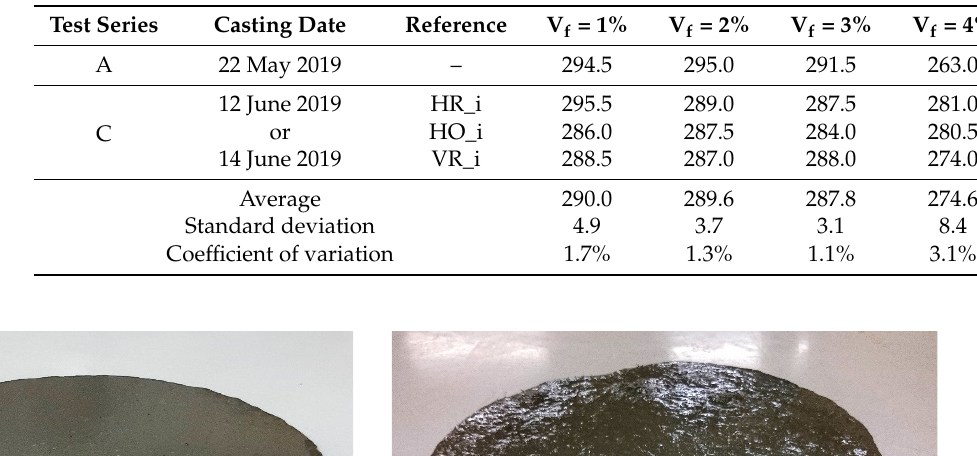
Table 5. Slump-flow diameter results (mm).